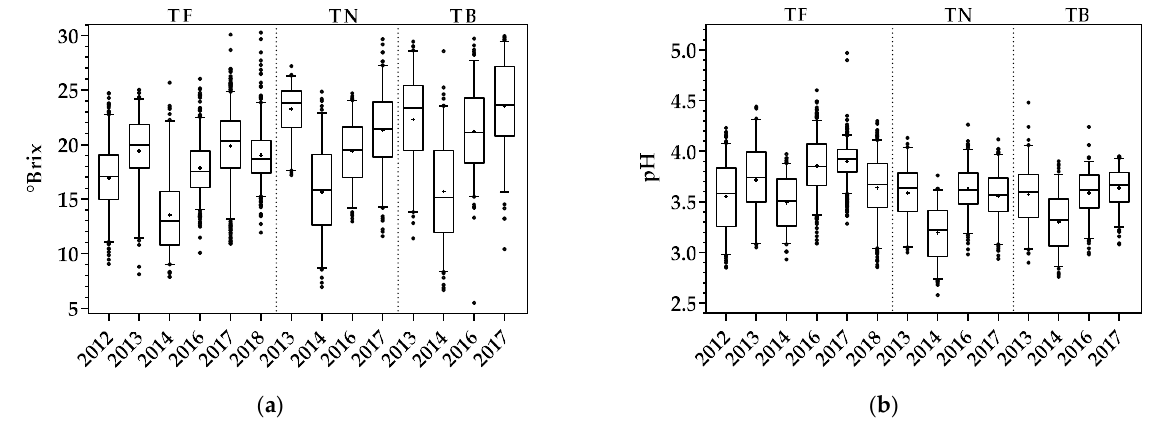
Figure 2. Sampling characterization for each vintage and variety: ( a ) sugar reference measurements; ( b ) pH reference Figure 2. Samplingcharacterizationforeachvintageandvariety: ( a )sugarreferencemeasurements; ( b )pHreferencemeasurements. measurements.